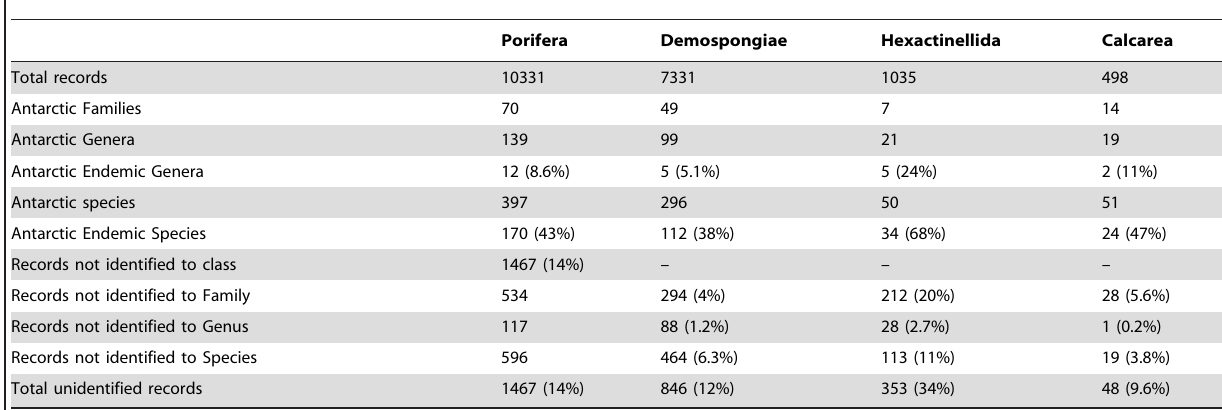
Table 1. Summary of all the sponge records held in the database created for this